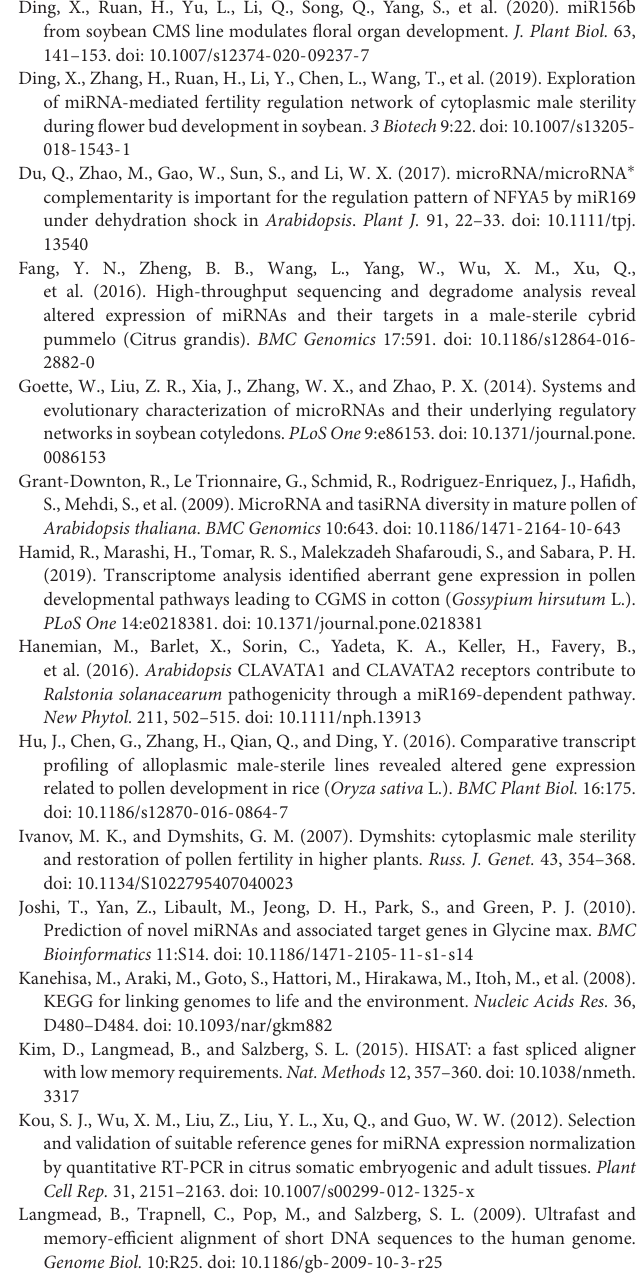
Supplementary Table 3 | Distribution of microRNA family members. Supplementary Table 4 | Summary of the identified microRNAs (miRNAs) and their families in JLCMS9A and JLCMS9B flower buds. Supplementary Table 5 | Overview of the degradome sequences from JLCMS9A and JLCMS9B. Supplementary Table 6 | microRNA (miRNA) target genes in JLCMS9A and JLCMS9B. Supplementary Table 7 | The primers sequence of in this